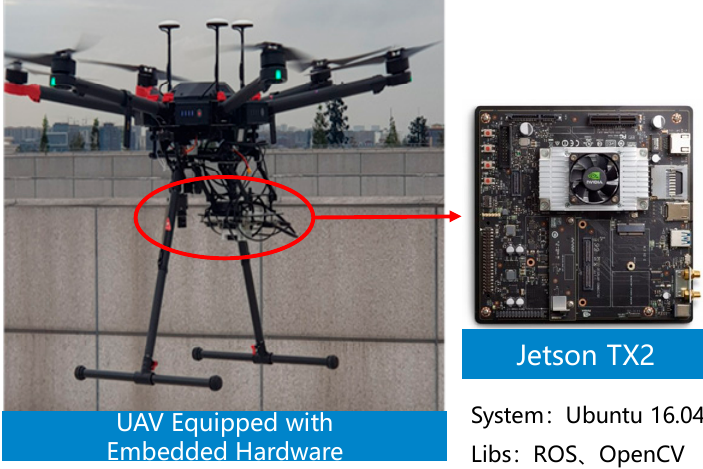
Figure 3. The hardware composition of the research system.